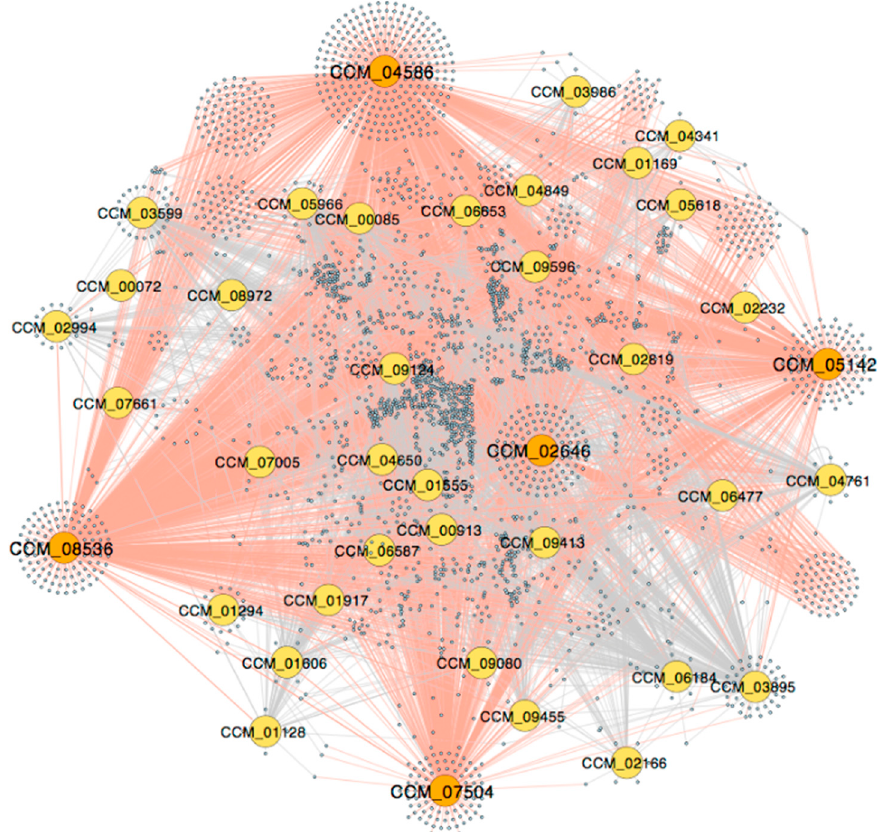
Figure 2. The light-responsive GRN. Five large orange nodes represent the key TFs that directly regulate almost over 90% of genes in the network. The direct regulation by the key TFs is labeled by red edges. Other TFs (non-key regulators) are shown as yellow nodes and other target genes are represented by small blue nodes.